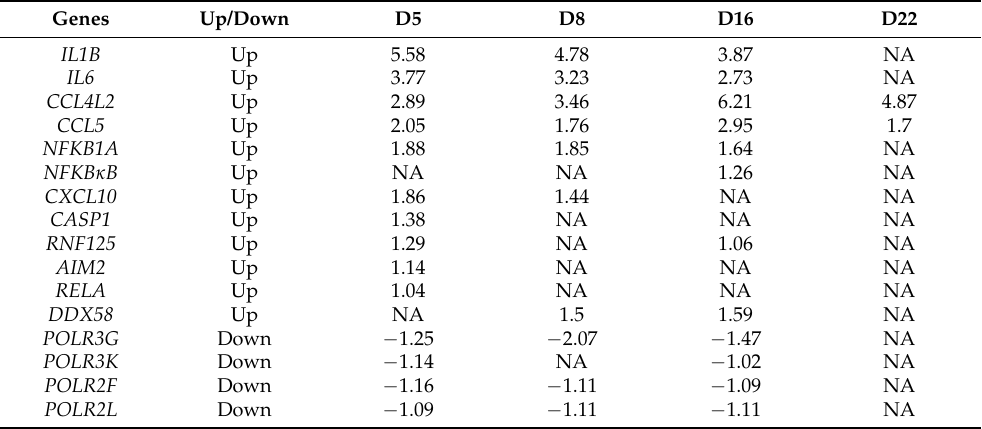
Table 1. The expression of differentially expressed (LogFC, compared to NT) genes sensing cyto- solic DNA triggered by the AIM2 inflammasome.